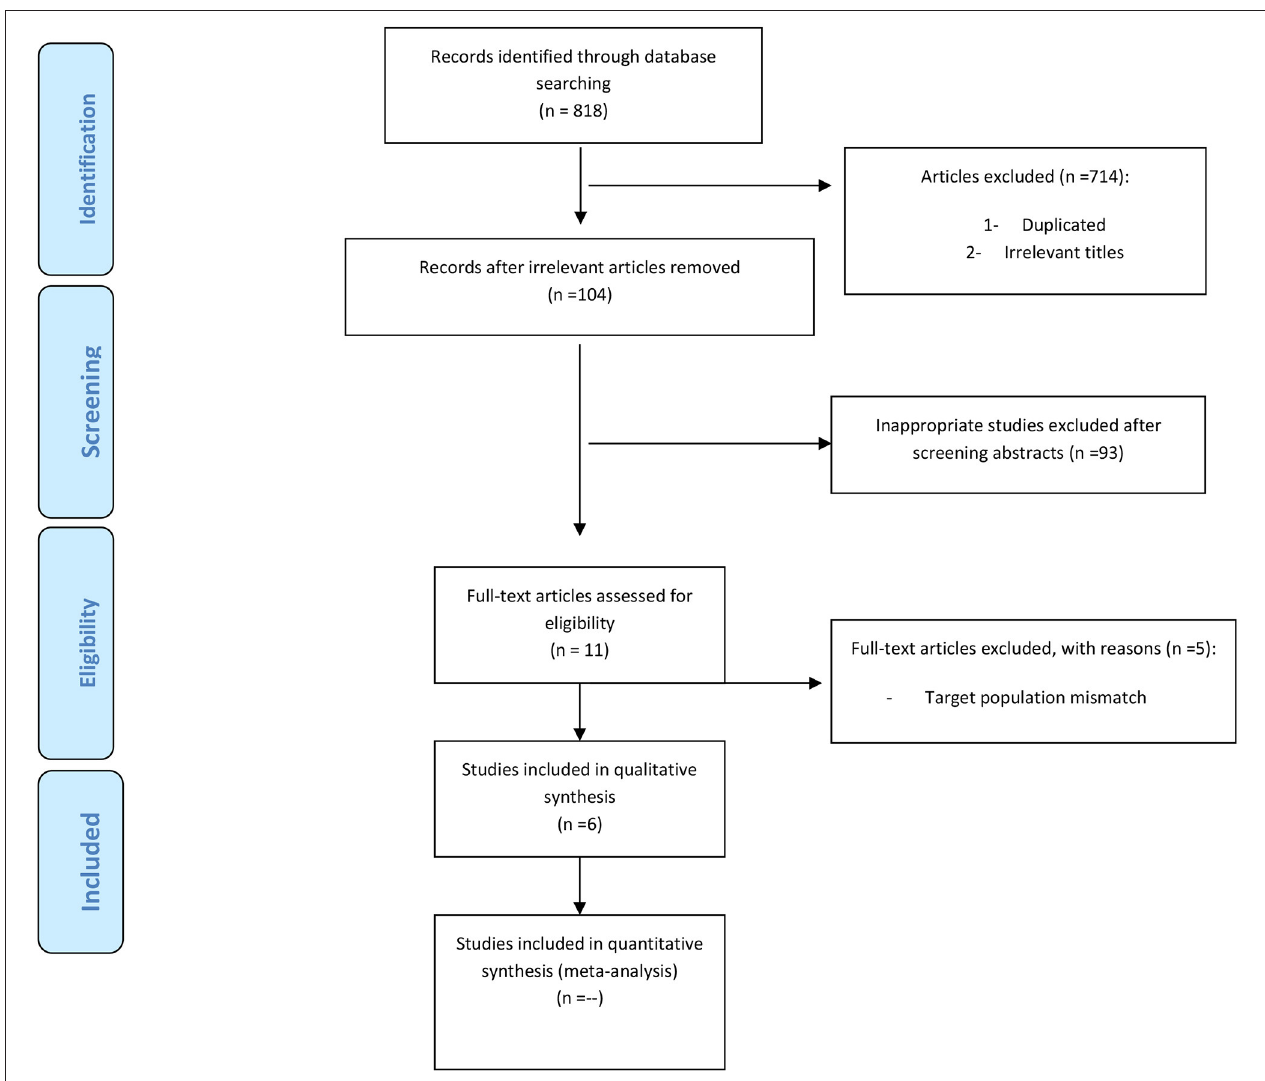
FIGURE 1 | PRISMA flow-chart of selected criteria for the included article reports.